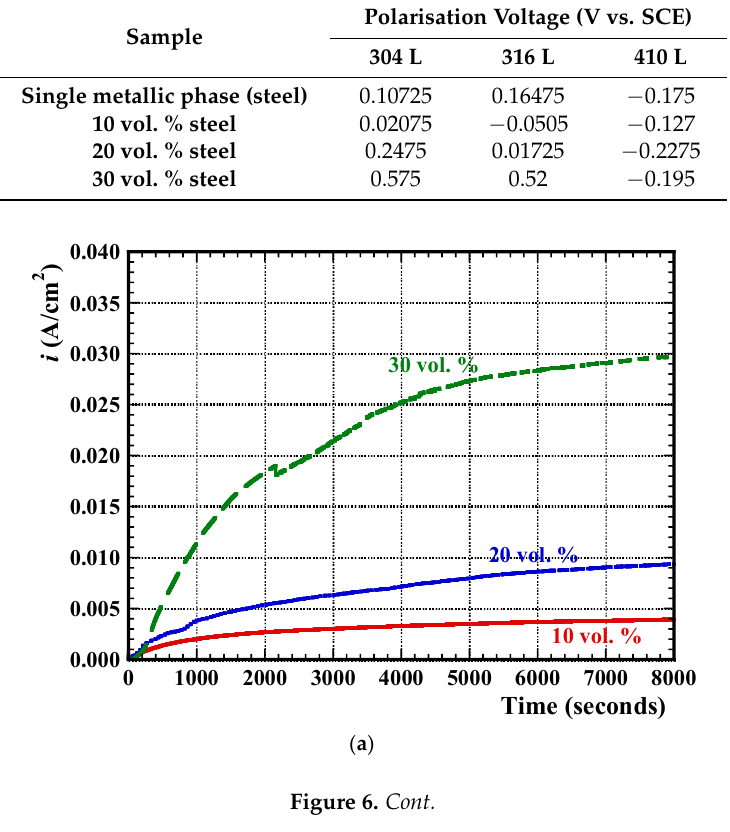
Table 6. The applied voltages used for potentiostatic polarisation testing of the TiC–stainless steel cermets and the single metallic phase.